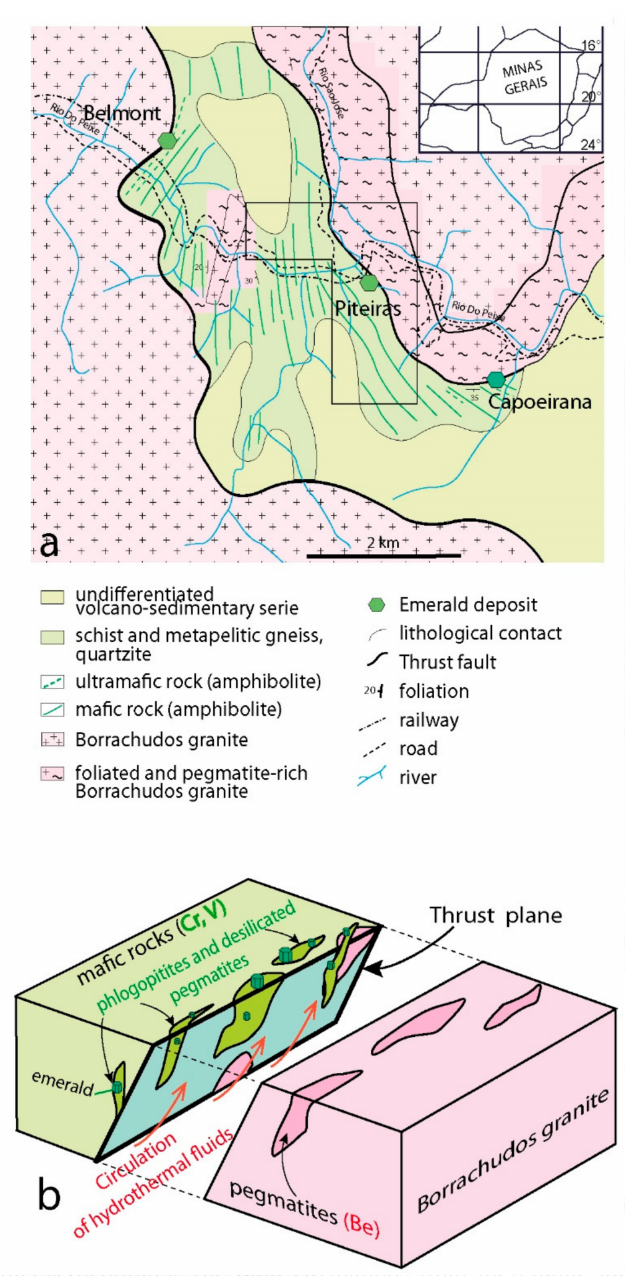
Figure 11. The emerald mining district of Itabira-Nova Era in Minas Gerais, Brazil, with the mines of Belmont, Piteiras, and Capoierana: ( a ) Geological map of the extended regional mining district. The mining concession of Piteiras is bounded by the polygon area plotted in the figure. Three deposits are currently mined. All occur in the same geological context. Ultramafic bodies (chromium—Cr, vanadium—V, and magnesium-rich-bearing rocks) are in contact with the deformed granites of Borrachudos (beryllium—Be, aluminium-silica-rich pegmatites), modified after [73]; ( b ) schematic diagram representing the probable formation of the Piteiras-Capoeirana-Belmont emerald deposits. During the Brasiliano orogenesis (508 Ma), the hydrothermal fluid (red arrows) circulated along the thrust planes, altering granites and associated Be-bearing pegmatites and Cr-V-bearing mafic-ultramafics. The hydrothermal fluids interacted with both rocks and were enriched in all the elements necessary for emerald crystallization. Emerald crystallized in plagioclasite (desilicated pegmatite) and